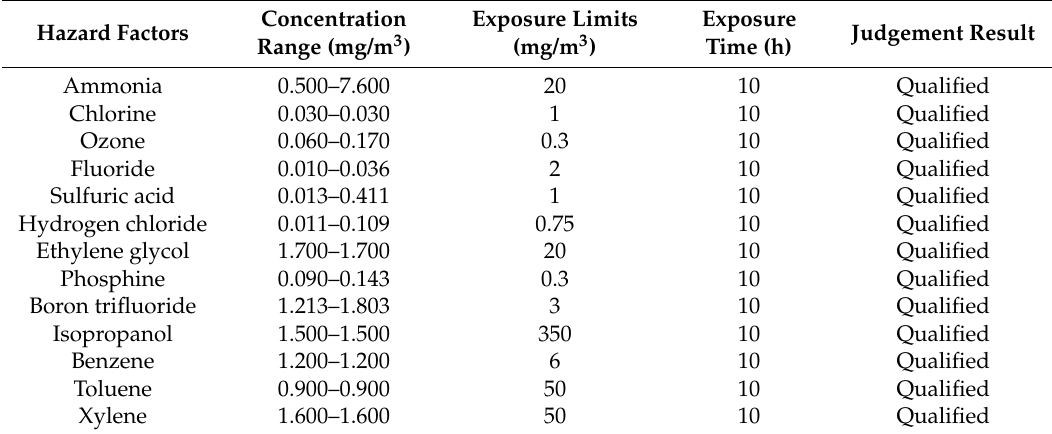
Table 4. Test results of occupational health hazard factors in the electronic chip manufacturing company.